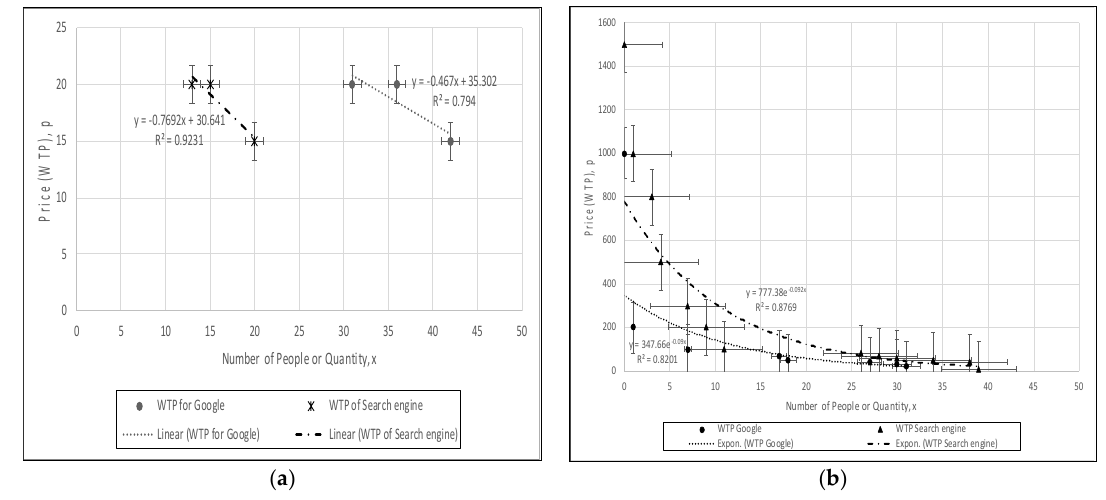
Figure 3. ( a ) Willingness-to-pay (WTP) fixed price schedule (per week); ( b ) willingness-to-accept (WTA) free price schedule (per week).